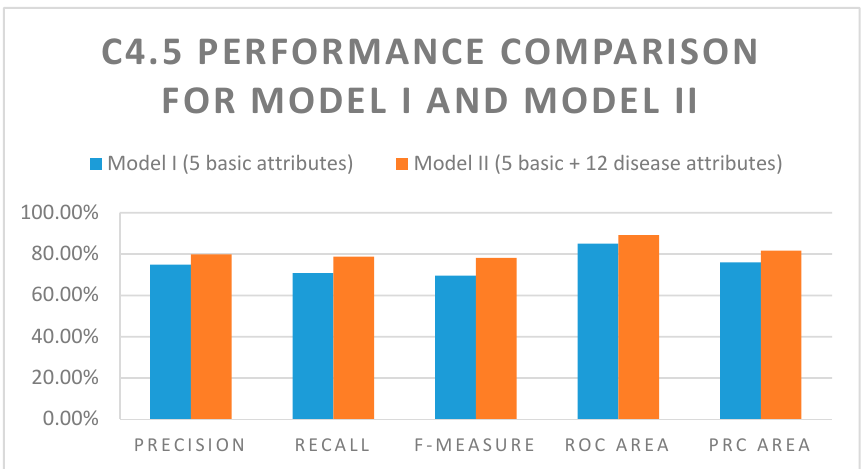
Figure 3. C4.5 algorithm performance comparison for Model I and Model II.